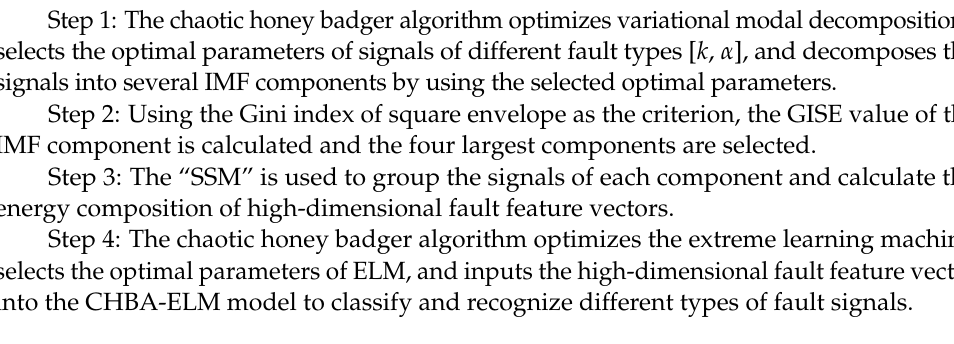
Figure 3. Flowchart of fault